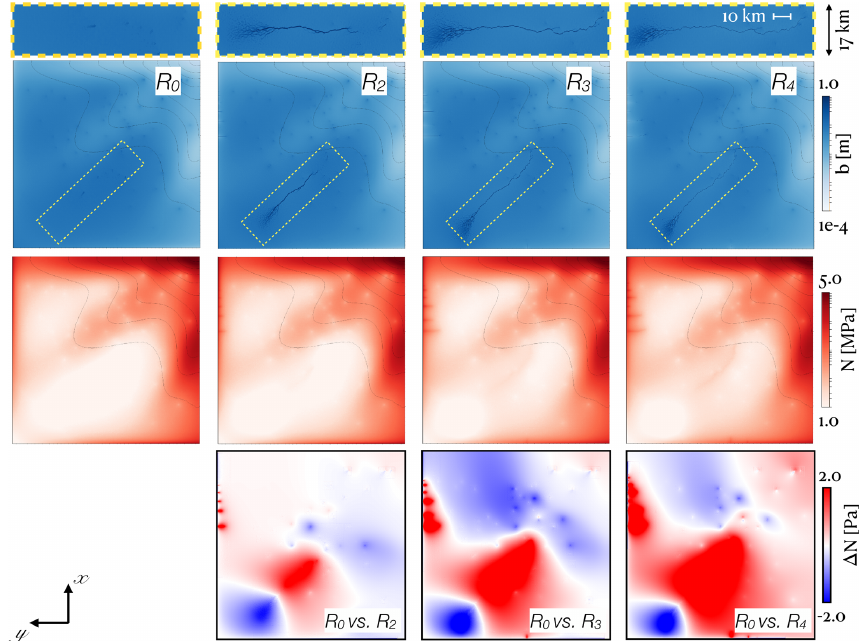
Figure 11. Fields of gap height (top two rows) and effective pressure (third row) for runs R 0 and R 2 to R 4 , with overlayed isocontours of bed elevation. For each run, a close-up of the channelizing area in the valley 1 region (see Fig. 9) is also displayed. The bottom row shows fields of effective pressure differences between R 0 and R 2 to R 4 , from left to